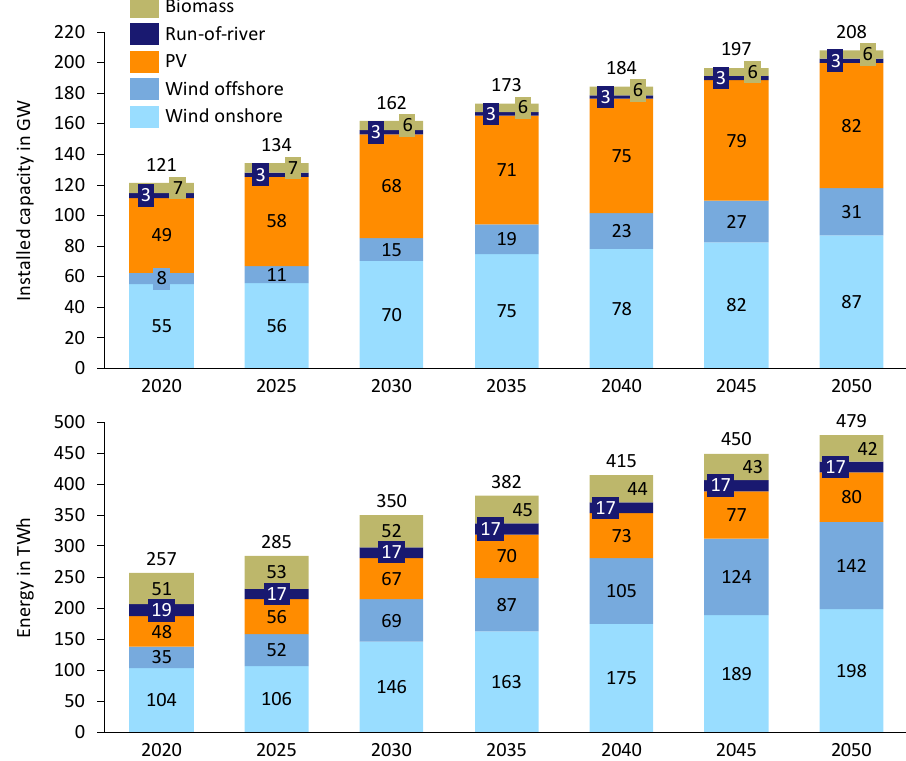
Figure 3. Installed variable renewable energy sources (vRES) and biomass capacities and yearly energy generation in Germany.